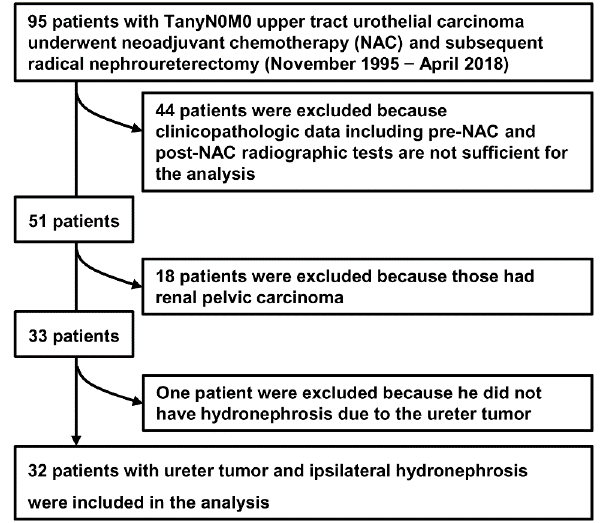
Figure 1. Flowchart for the creation of the cohort data set.